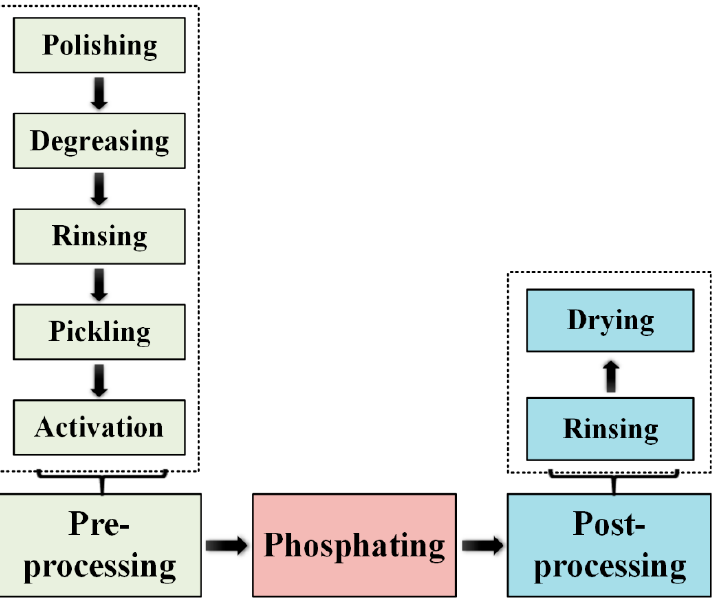
Figure 1. Flow chart depicting the processing procedures involved in the fabrication of phosphate chemical conversion coating on metal substrates.